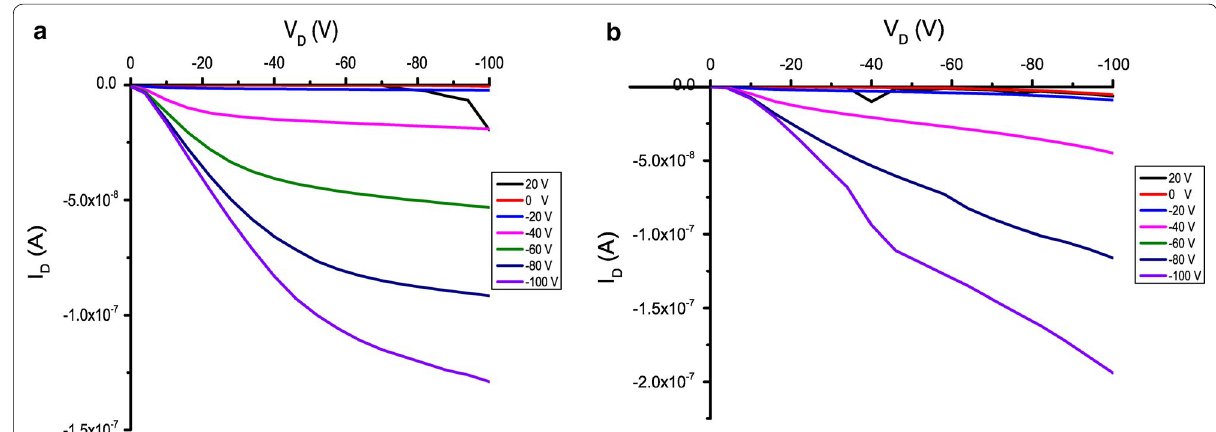
Fig. 4 Output characteristics of CBZ-BODIPY-CBZ a before and b after